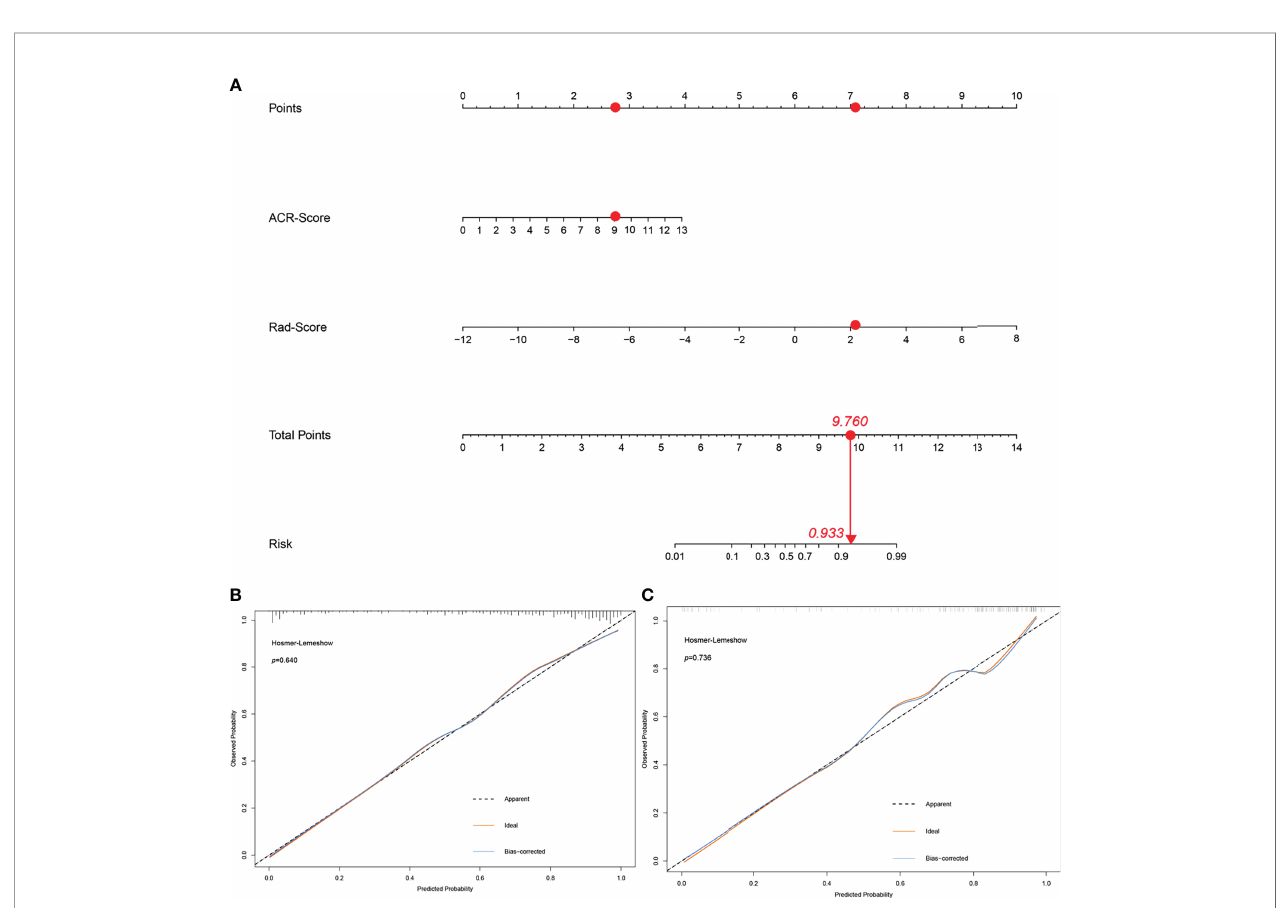
FIGURE 3 | The ACR-Rad nomogram to predict malignancy in thyroid nodules (A) and calibration curves of the nomogram in the training (B) and validation (C) cohort. Red dots described the calculation process of an ACR-Rad nomogram point of a malignant thyroid